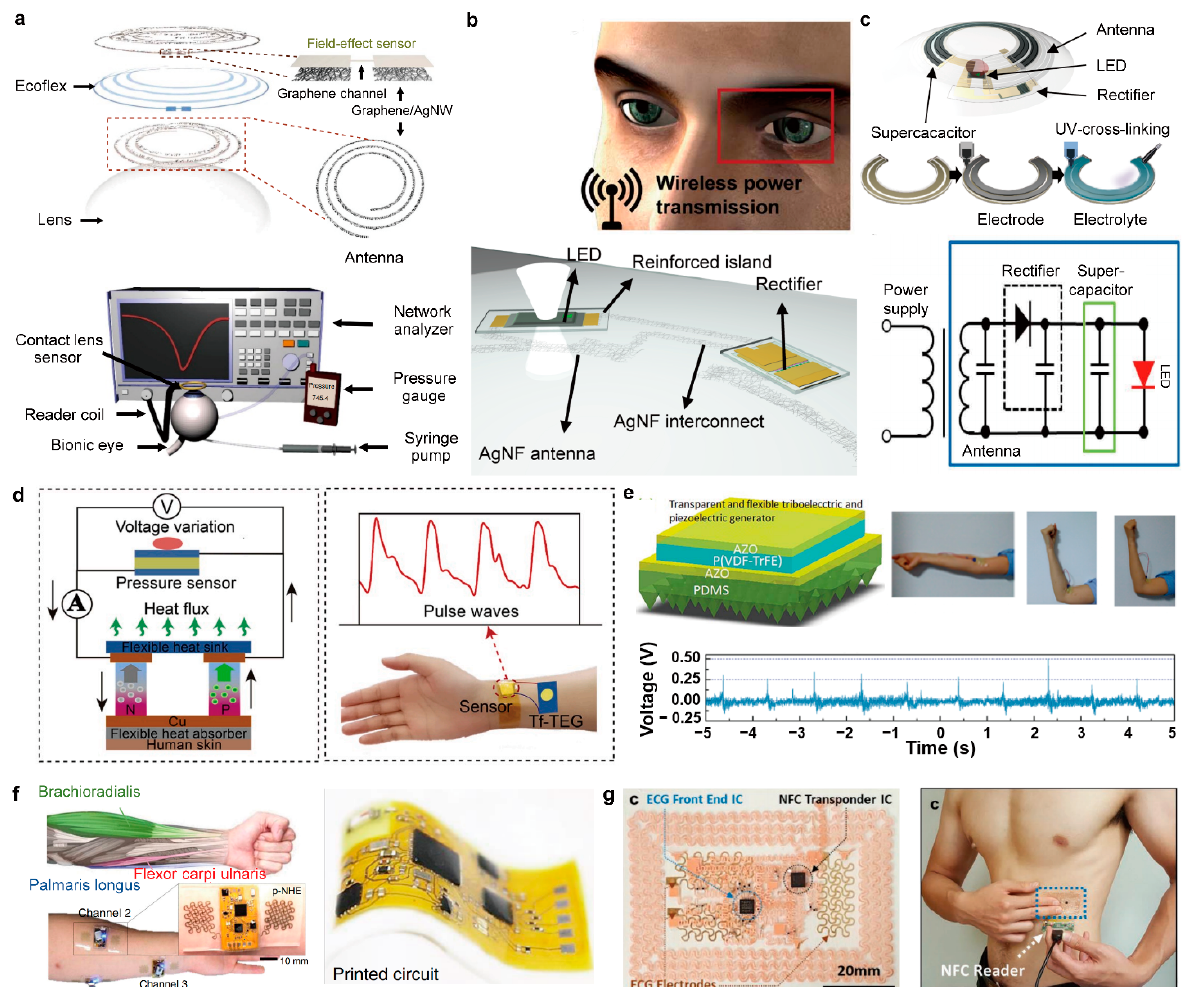
Figure 6. ( a ) Wireless power and data transfer between a smart contact lens and a network analyzer via inductive coupling (reprinted with permission from [144]. Copyright 2017 Springer Nature); ( b ) Smart contact lens with a wireless power transfer circuit and a LED display (reprinted with permission from [15]. Copyright 2018 American Association for the Advanced Science); ( c ) Smart contact lens integrated with a wireless power transfer circuit, LED pixel, and printed solid-state supercapacitors for continuous operation (reprinted with permission from [145]. Copyright 2019 American Association for the Advanced Science); ( d ) Self-powered wearable patch for continuous monitoring of pressure driven by a flexible thin-film thermoelectric generator (reprinted with permission from [146]. Copyright 2020 Elsevier B.V); ( e ) Triboelectric